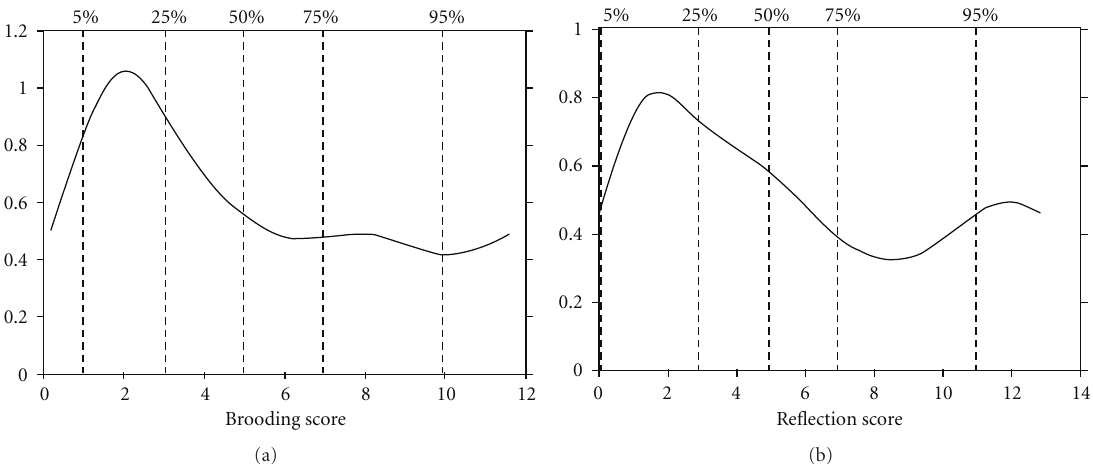
Figure 1: Test information function for the brooding subscale (a) and the reflection subscale (b), with estimated scale scores on the horizontal axis and test information on the vertical axis. Note: the vertical dashed lines indicate (from left to right) the 5th, 25th, 50th, 75th, and 95th percentiles of the observed score distribution, respectively.